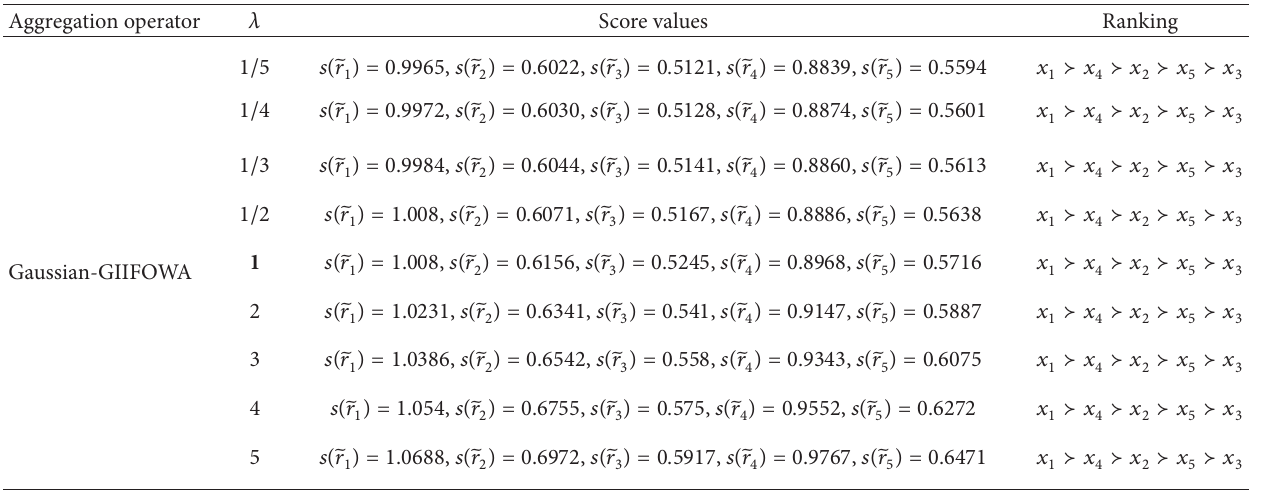
Table 10: Ranking results obtained by applying Gaussian-GIIFOWA on assessments given by 𝑑 1 . Aggregation operator 𝜆 Score values